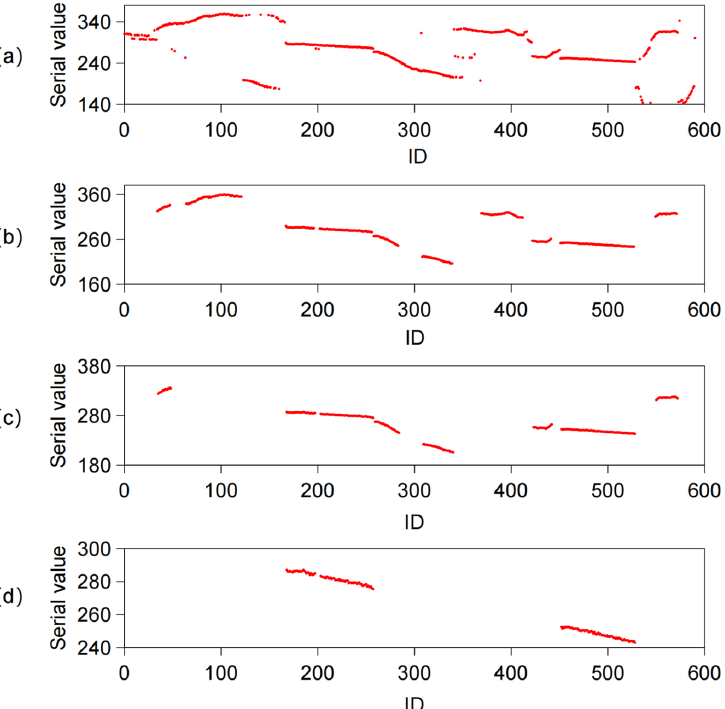
Figure 13. Results of line fitting preprocessing: ( a ) Original sequence; ( b ) Continuity Processing’s Outcome: ( c ) Linearity Processing’s Outcome: ( d ) Co-linear Processing’s Outcome.